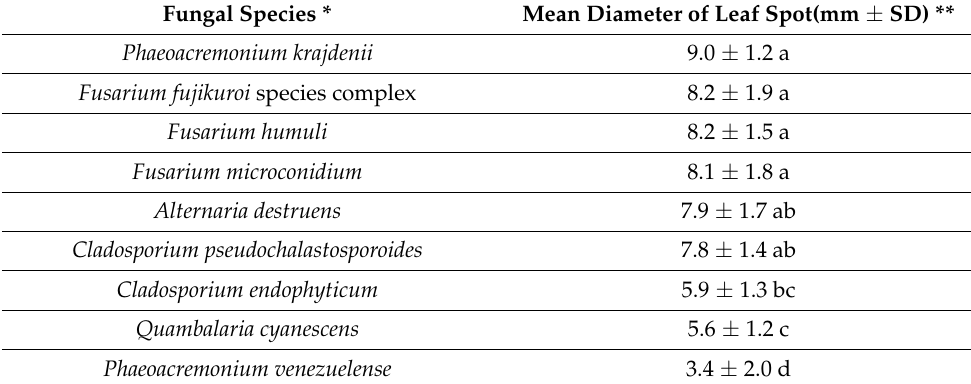
Table 3. Pathogenicity test of fungal species on date palm